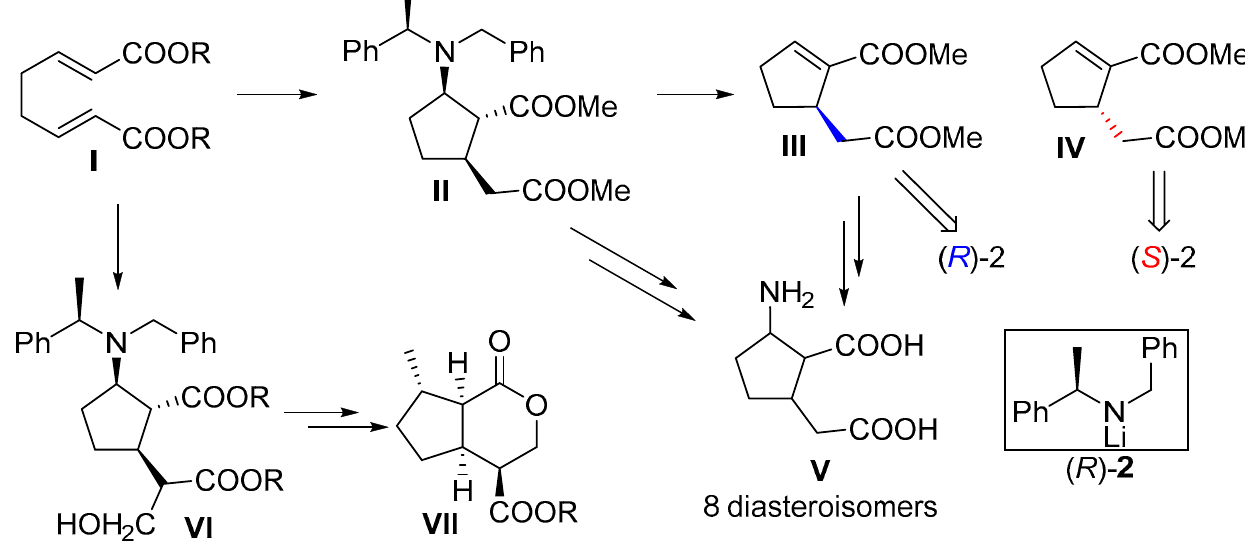
Scheme 1. Cyclopentane derivatives obtained from octadiendioates by domino